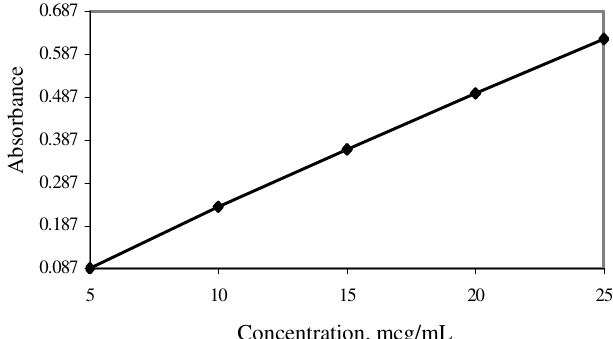
Figure 2. Calibration curve for losartan potassium using phosphate buffer as a